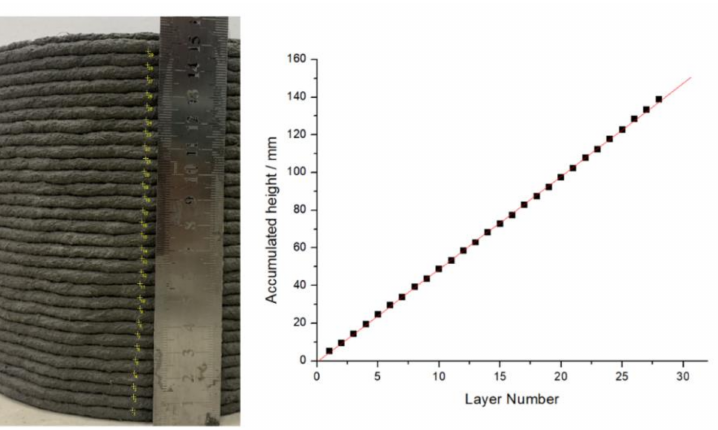
Figure 10. The printed hollow cylinder D200V40OSS3 with measuring points ( left ) and the accumu- lated height ( right